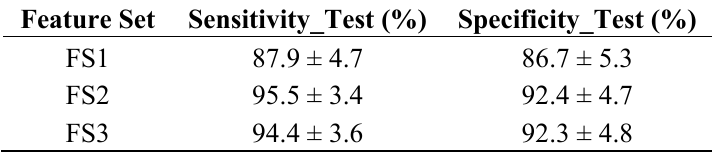
Table 5. Sensitivity and specificity of the two-class classification using different feature sets.